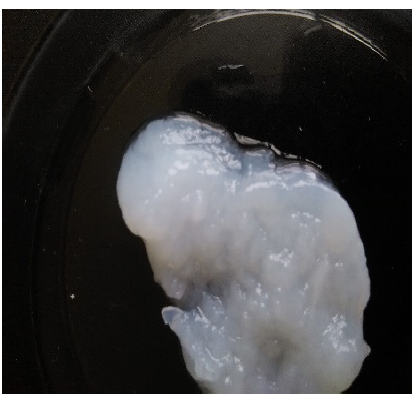
Figure 2. Appearance of dispersion containing 1.23% of BC.